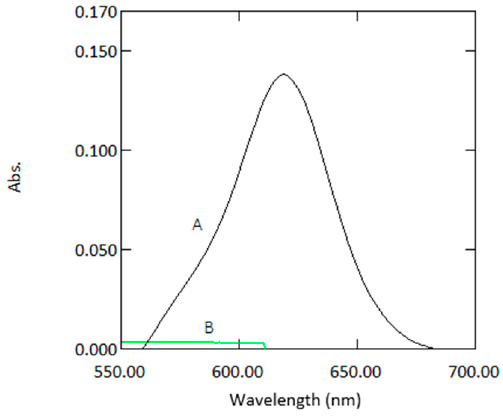
Figure 1. Absorption spectra of coloured species (1 μ g mL − 1 arsenic) versus reagent blank (A) and reagent blank versus double deionized water (B).